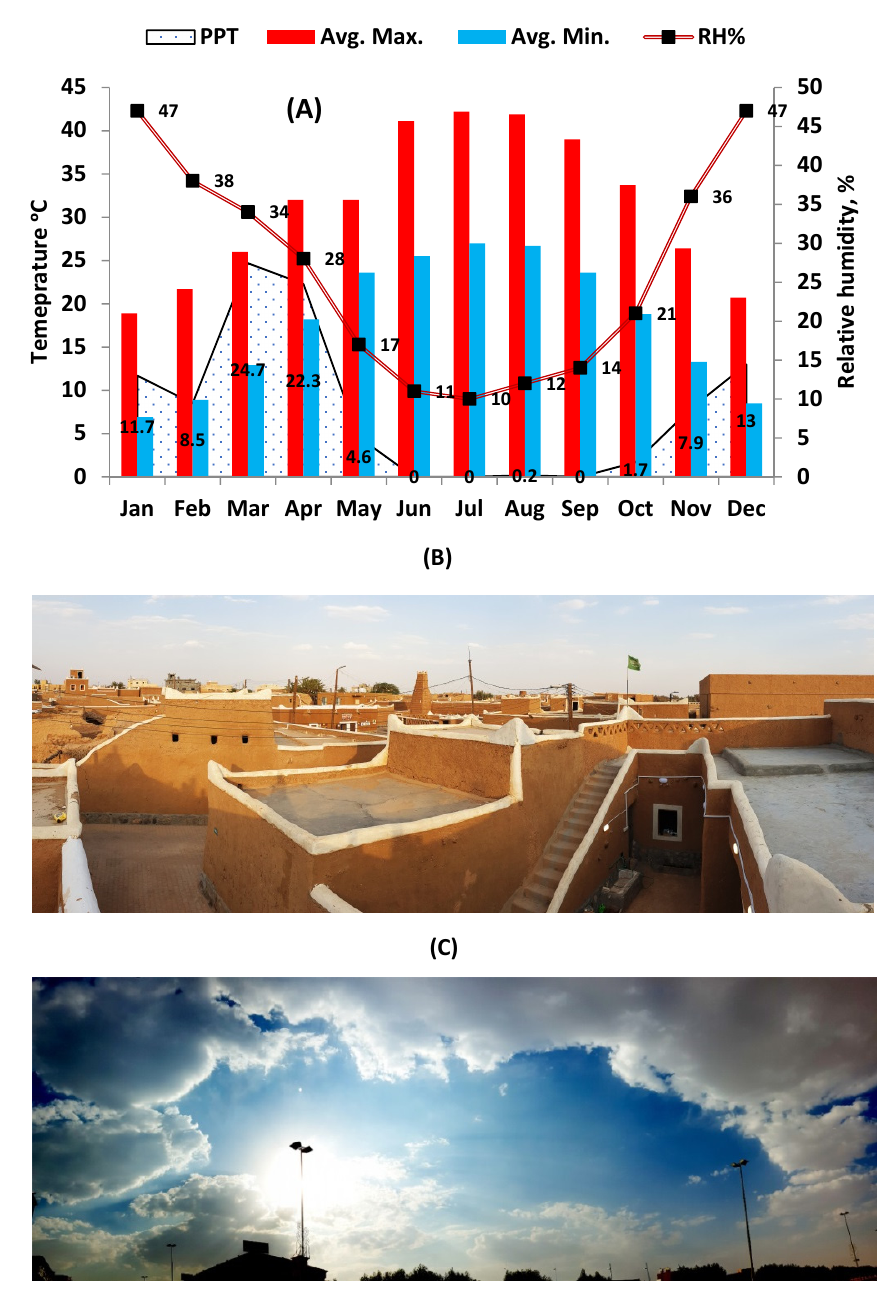
Figure 1. Weather data for Al-Dwadimi town ( A ) (Meteonorm, 2019), and Ash Shu’ara heritage village in Al-Dwadimi town, ( B , C ) is the cloud cover during the measurement day (Taken by the author).